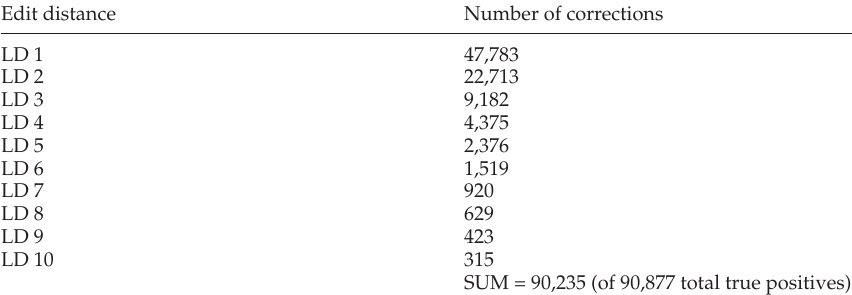
Table 5: Number of corrected words with edit distances of 1–10: 99.2% of all the true